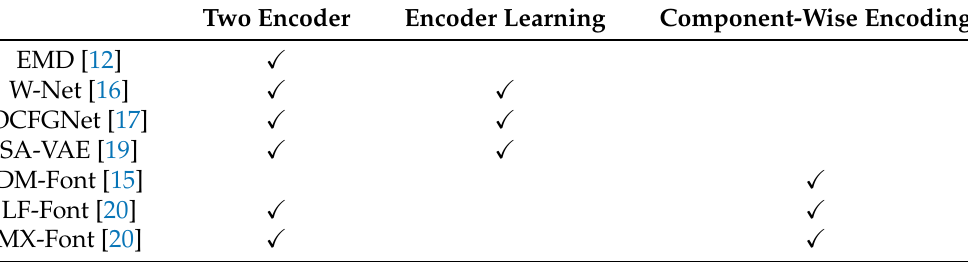
Table 1. Summary of the font generation works. Two encoder means that they split the encoder for content and style. Encoder learning denotes that they proposed the additional loss for the encoder. Component-wise encoding means that they extract the component feature that makes up a